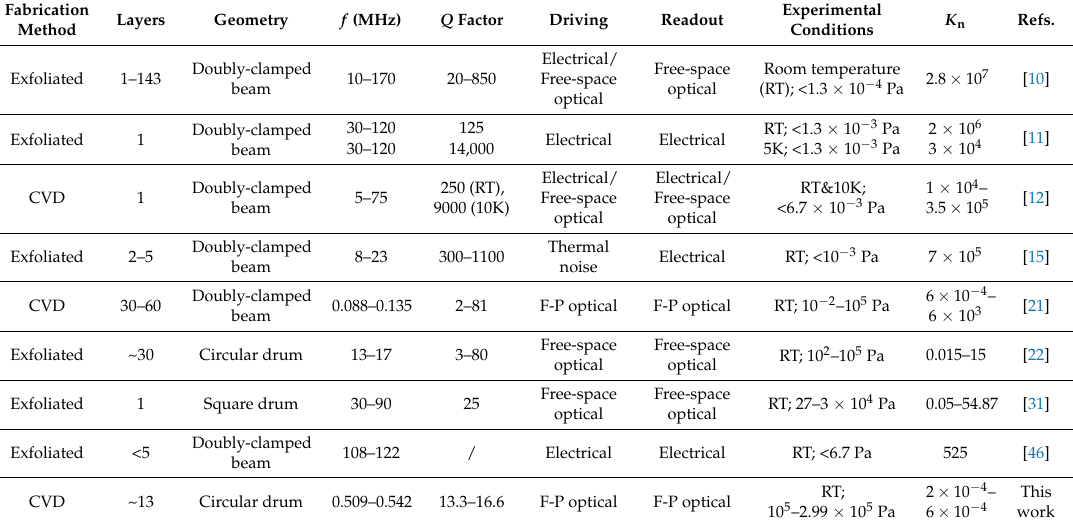
Table 1. Summary of the experimental works on graphene nanomechanical resonators. Fabrication